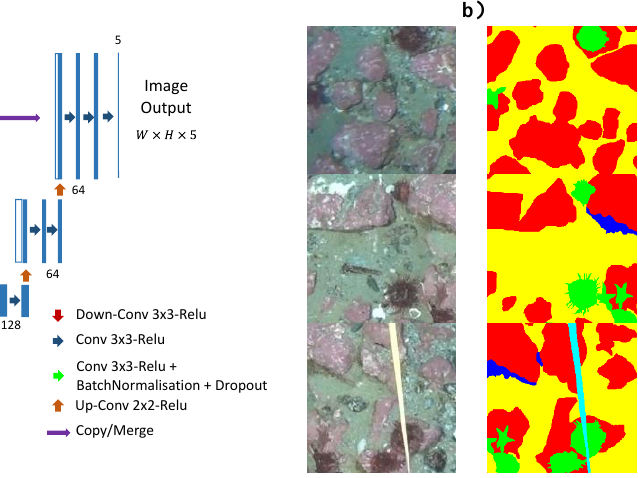
Figure 3 . Architecture of the U-NET convolutional neural network (CNN) used for semantic segmentation of the sea bottom (a). Example of training images (b) showing the RGB image patches and their corresponding ground truth (5 classes – see description in the